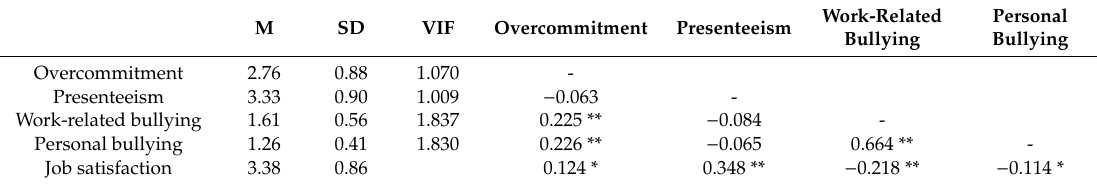
Table 1. Descriptive